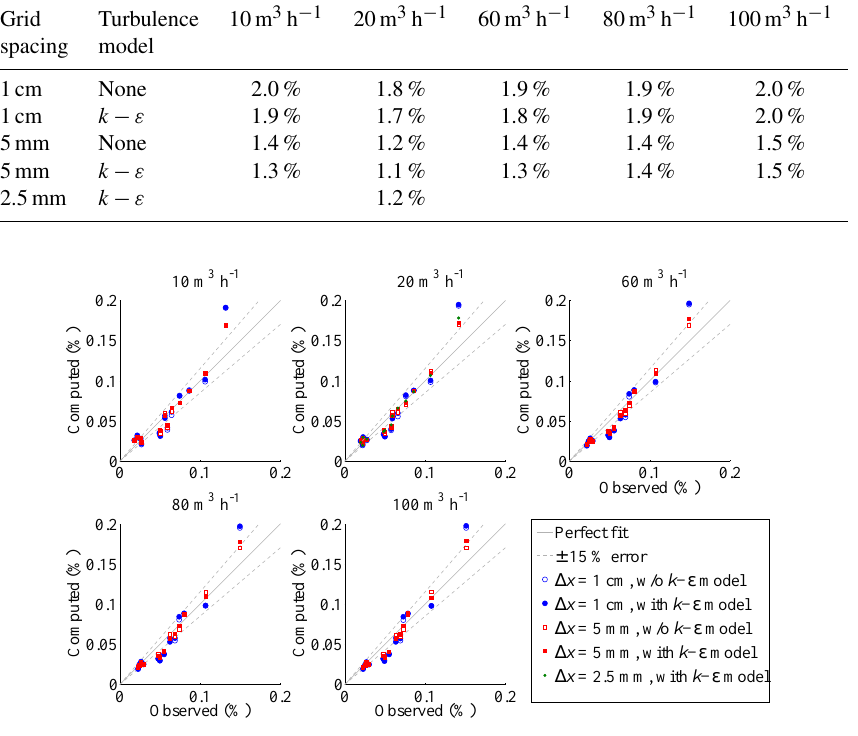
Figure 8. Computed vs. measured outflow discharges in each street (in percent of the total inflow) considering different cell sizes (cid:49)x in the computation, with or without the turbulence model.